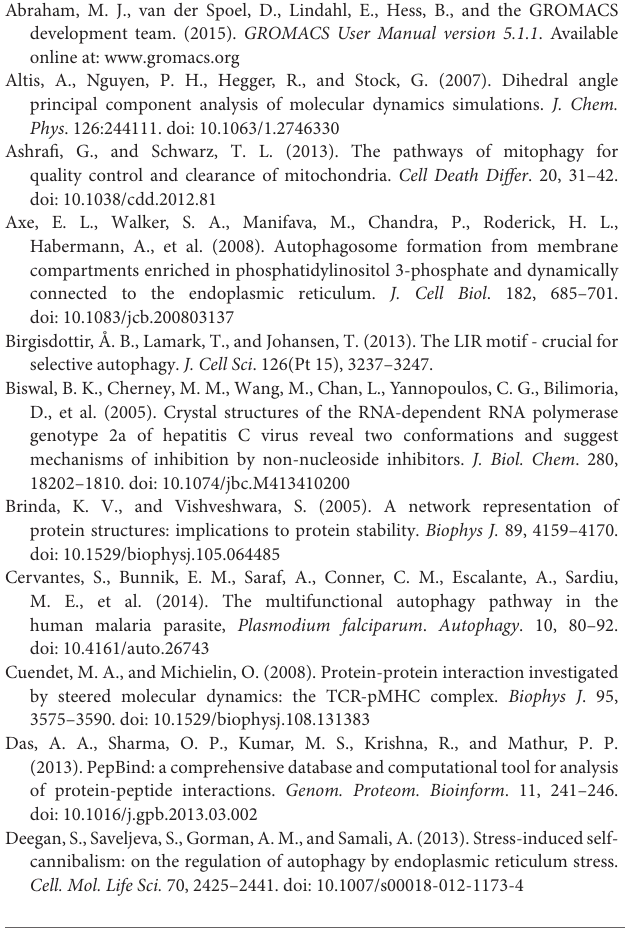
Figure S2 | RMSDs computed for the backbone atoms of the various AIM/LIR— Pf Atg8/ Hs LC3 complexes, as a function of time. The RMSDs computed over the entire 50 ns MD trajectory were indicated in red color, whereas the RMSDs calculated for the trajectory of conformations obtained from dihedral PCA are indicated in black color. Figure S3 | Pull distance computed for the AIM/LIR— Pf Atg8/ Hs LC3 complexes, as a function of time at a constant velocity of (A) 0.010 nm/ns and (B) 0.025 nm/ns. Table S1 | List of identified AIM/LIR motifs in Pf Sec62